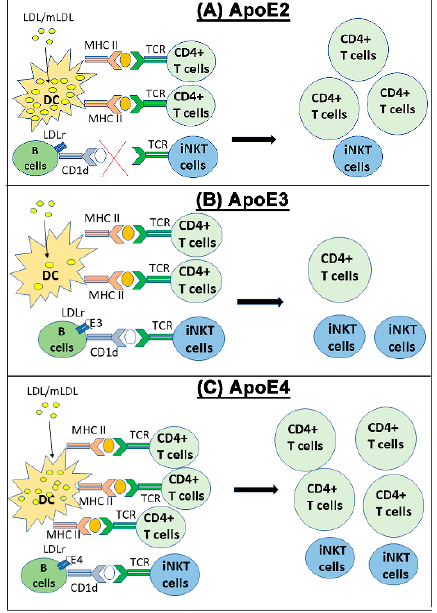
Figure 1. Schematic diagram depicting the influence of various apoE isoforms on antigen presentation. ( A ) ApoE2 enhances intracellular cholesterol accumulation after dendritic cell uptake of LDL/modified LDL to enhance MHC-II expression, thereby promoting antigen presentation to CD4 + T lymphocytes for their activation. The defective apoE2 binding to the LDL receptor in B lymphocytes also impairs CD1d-mediated antigen presentation and iNKT cell activation. ( B ) ApoE3 limits intracellular cholesterol levels in dendritic cells, thereby reduces MHC-II expression and T lymphocyte activation. ApoE3 also interacts with the LDL receptor on B lymphocytes to enhance CD1d-mediated antigen presentation to iNKT cells. ( C ) ApoE4 enhances intracellular cholesterol accumulation in dendritic cells to enhance MHC-II expression and antigen presentation for T lymphocyte activation. ApoE4 also interacts with the LDL receptor on B lymphocytes to enhance CD1d-mediated antigen presentation to activate iNKT cells.